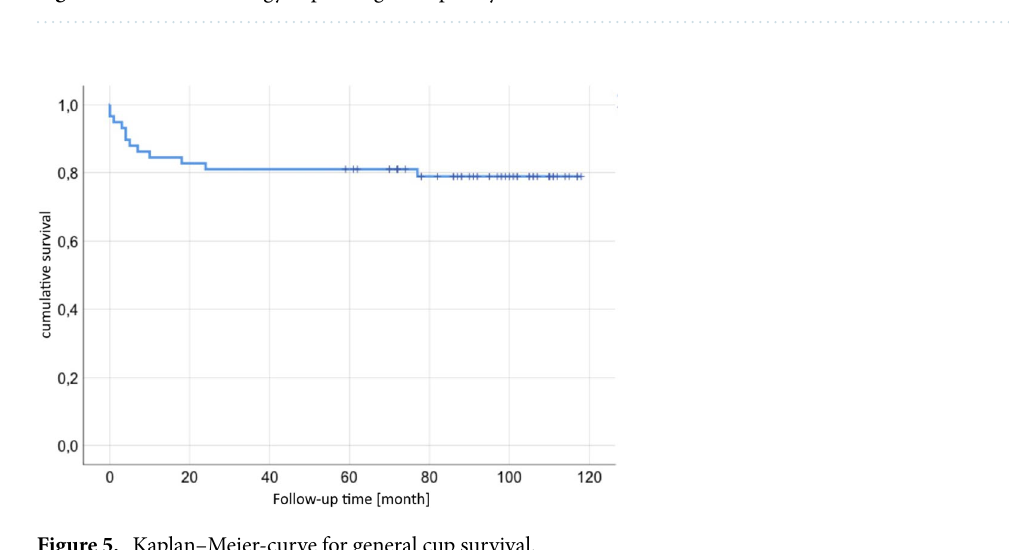
Figure 4. Revision strategy depending on Paprosky classification.